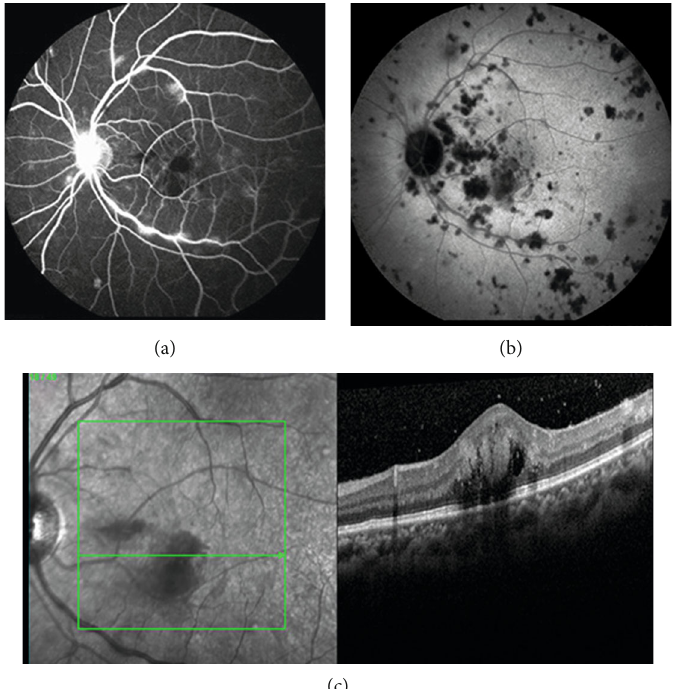
Figure 2: Case 1: left eye at presentation. (a) Late-phase fl uorescein angiogram (FA) showed vasculitis of large venous vessels, hot disc, some macular hypo fl uorescent lesions, and mild di ff usion at the level of some central lesion and midperipheral probably retinal lesions. (b) Indocyanine green angiography demonstrated numerous hypo fl uorescent spots, more numerous than the lesions seen on eye fundus and FA, suggesting associated widespread choroidal lesions. (c) Macular spectral domain optical coherence tomography demonstrated retinal in fi ltration in the inferior part of the macula with a di ff use